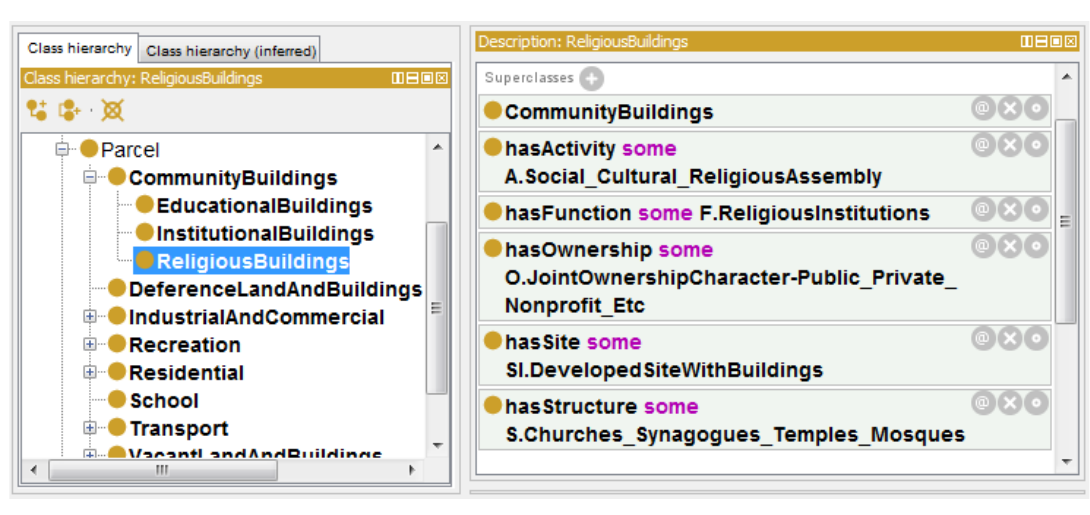
Figure 4. Matching between NLUD and LBCS. Matching between the NLUD class “ReligiousBuildings” and the LBCS ontology concepts through existential restrictions in the dimensions